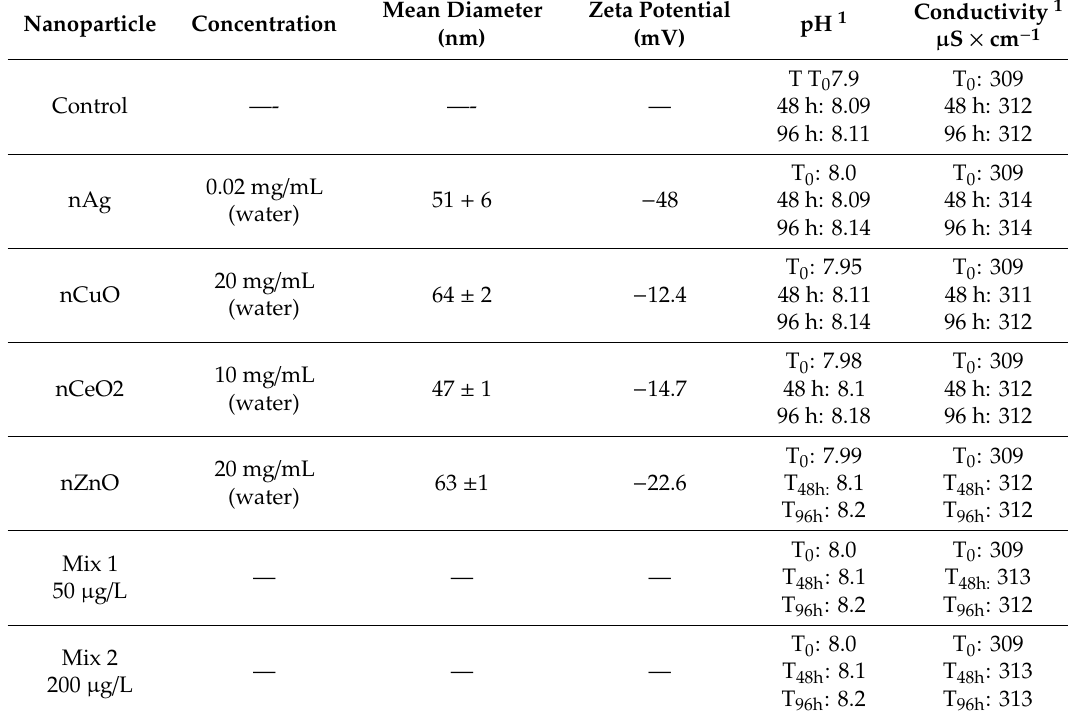
Table 1. Physico-chemical properties of nanoparticles and their